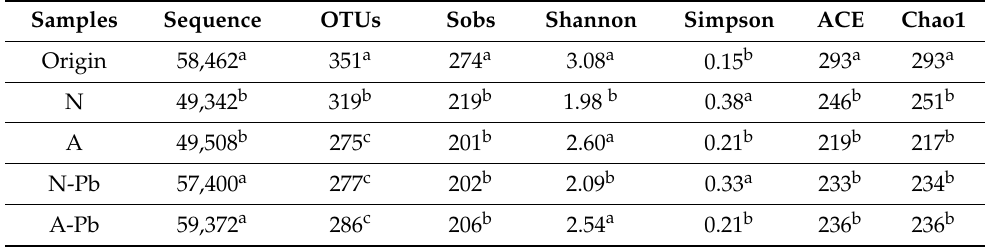
Table 3. Abundance and diversity of fungal and bacterial communities associated with litter decomposition.